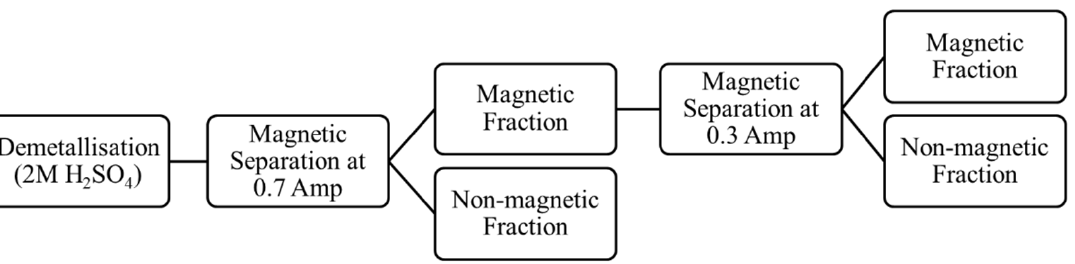
Figure 12. Schematic of the demetallisation and magnetic separation process routes tested (using tail sample from Flotation Test‒3). Table 2. Identification of samples obtained after the demetallisation and magnetic separation process (using tail sample from Flotation Test-3).